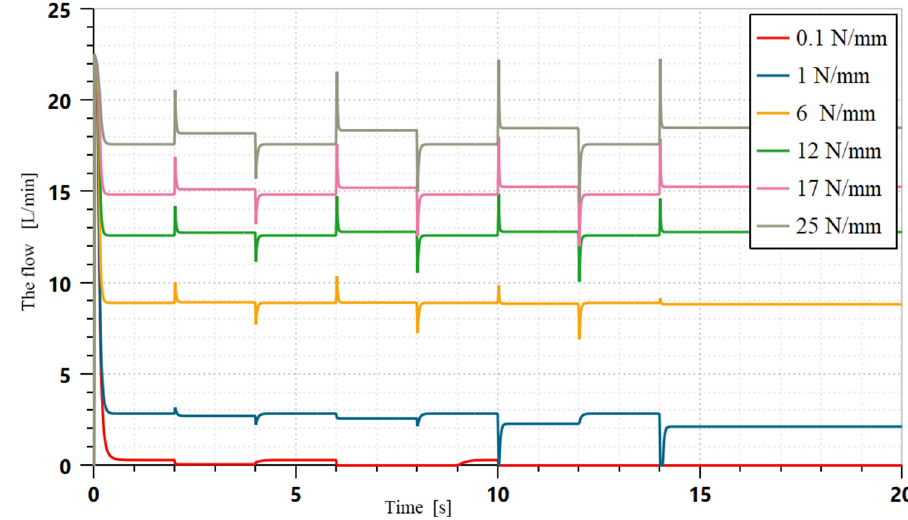
Figure 8. Influence of different spring stiffnesses on flow-rate fluctuation.